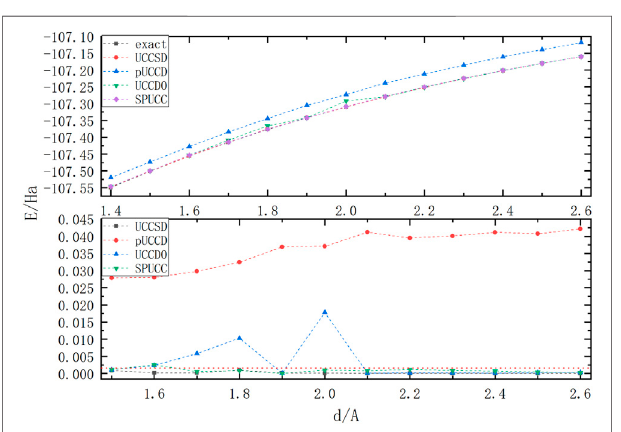
FIGURE 4 | A graph in which the energy of a molecule N 2 varies with bond length (6 electrons and 10 orbitals). The above picture shows the curve of the energy of each method in the bond dissociation region with the bond length, and the diagram below shows the relationship between the differencebetweeneachmethodandthediagonalizationenergyandthebond length.Thereddottedlinerepresents thechemicalprecisionof1 . 6 × 10 − 3 Ha .